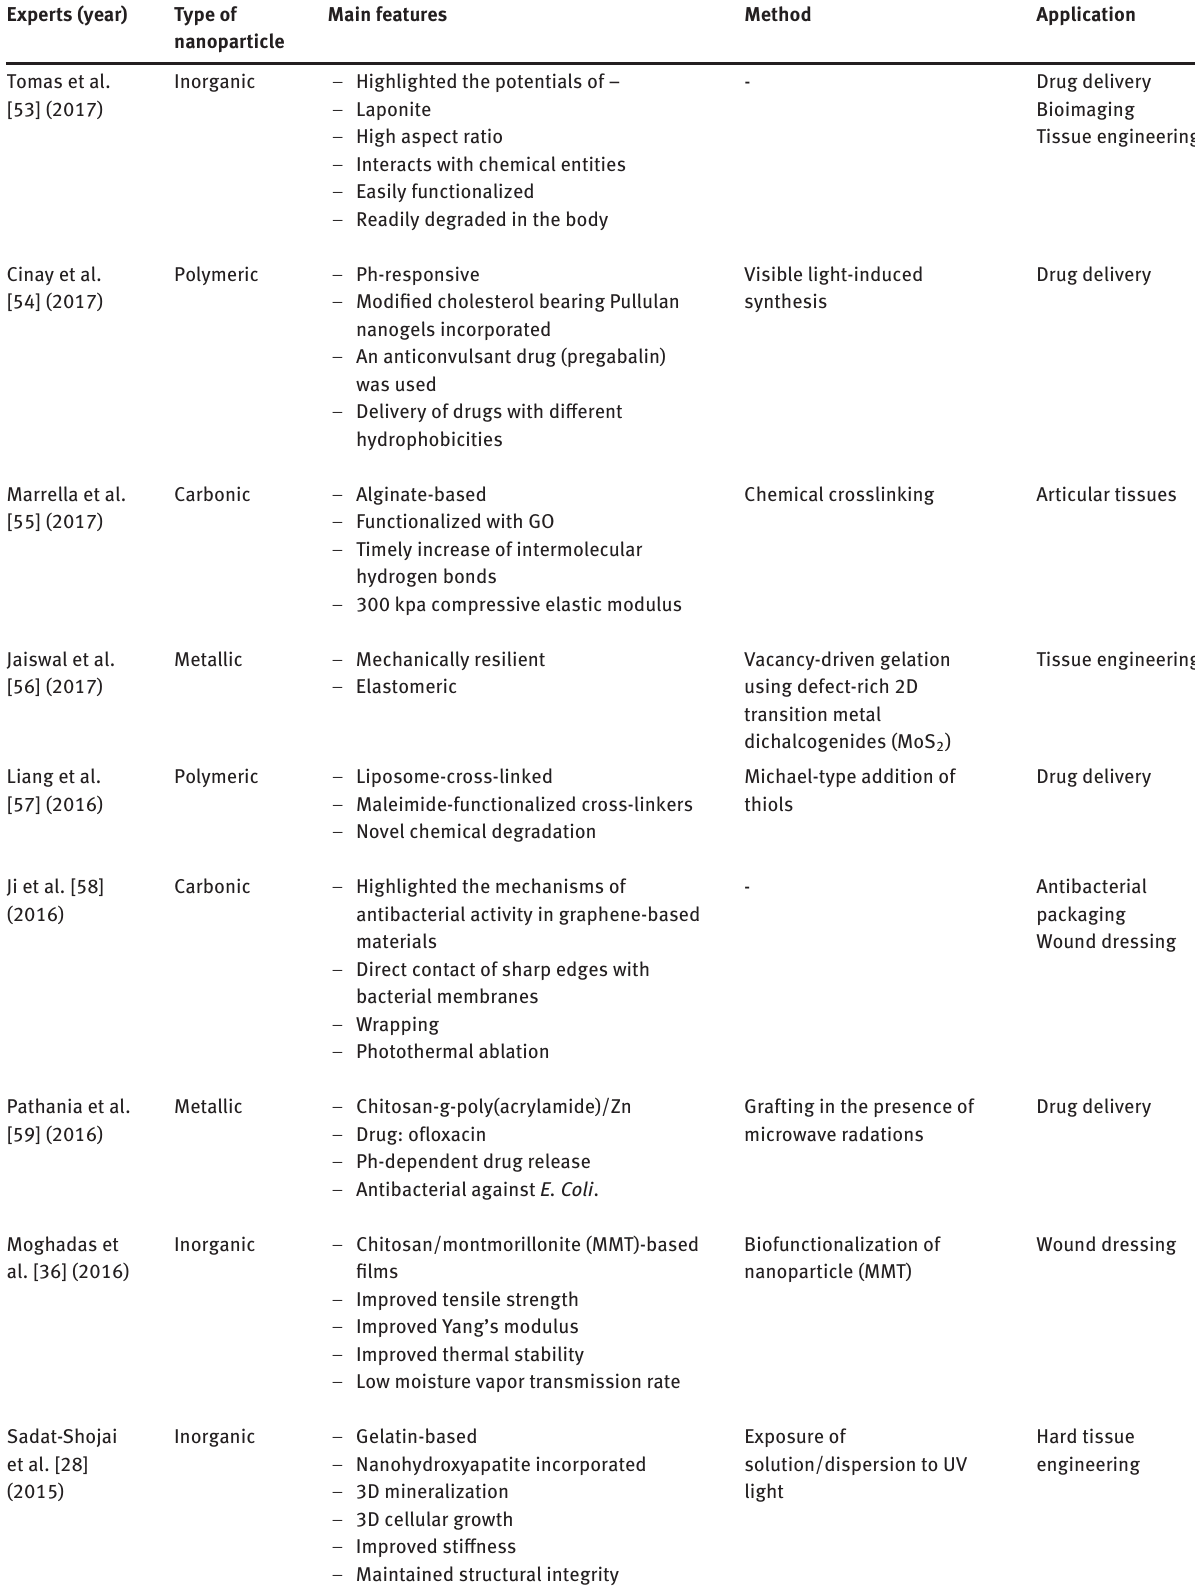
Table 1: Some important works in the field of nanocomposite hydrogels (NCHs) in the last 5 year. Experts